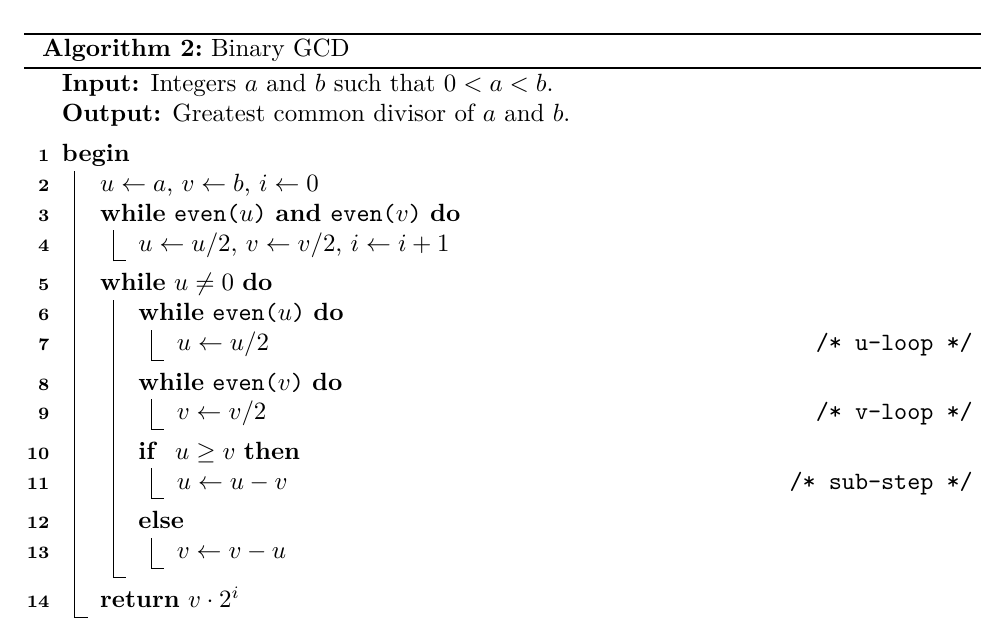
Figure 1: LS-encoded binary GCD execution flow